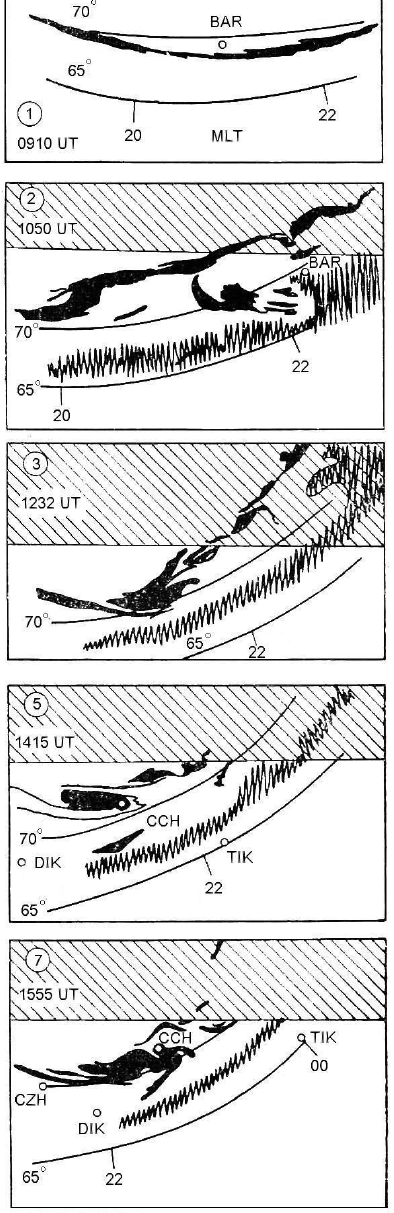
Figure 32. Schematic auroral display from DMSP spacecraft frames in the coordinates of corrected geomagnetic latitude–MLT. Locations of magnetic observatories are marked by dots. The num- ber of frame is indicated by a digit in the ring (Sergeev and Vorob- jev, 1979).